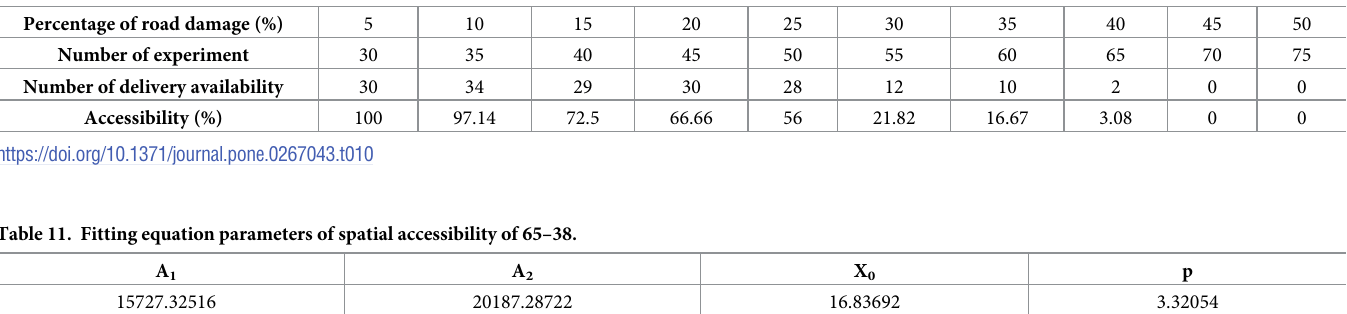
Table 10. Simulation tests of spatial accessibility of 65–38.